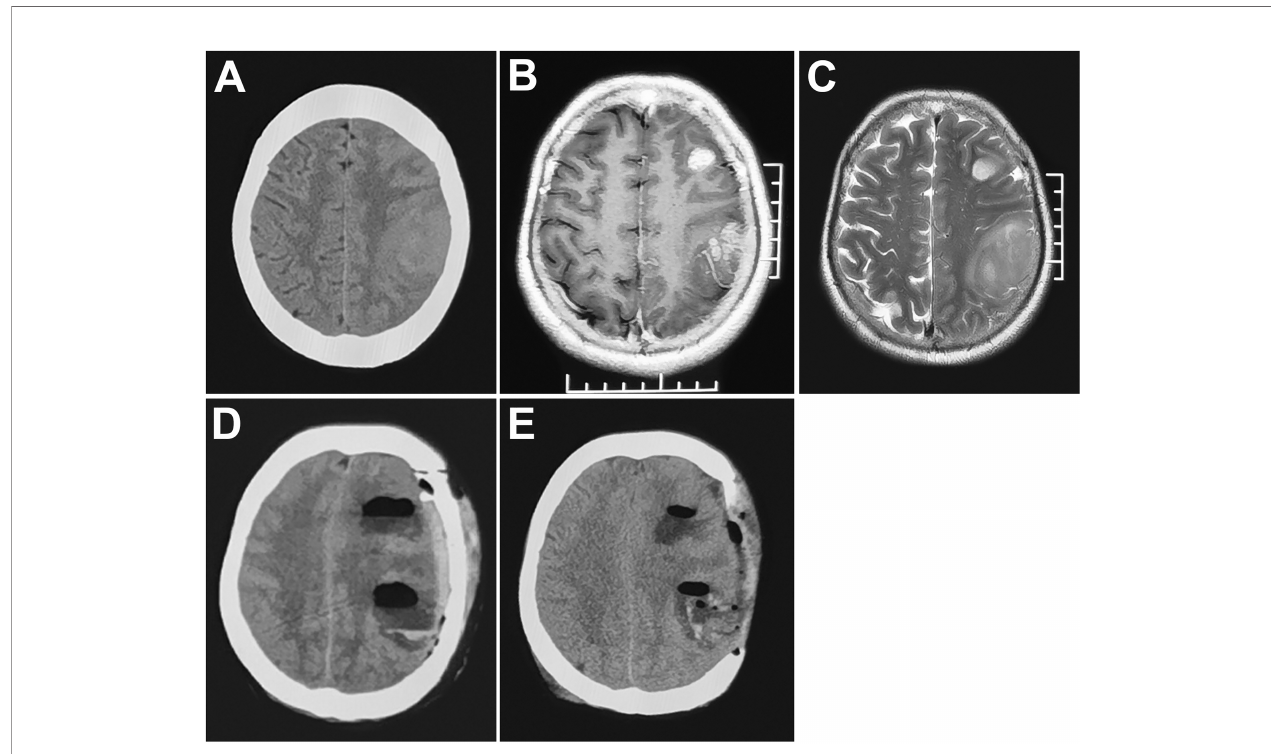
FIGURE 2 | MRI (A – C) multiple gliomas in the left frontoparietal lobe. CT (D) obvious midline shift and cerebral venous infarction (cortical veins were injured during the operation) 72 hours postoperatively. (E) decompressive